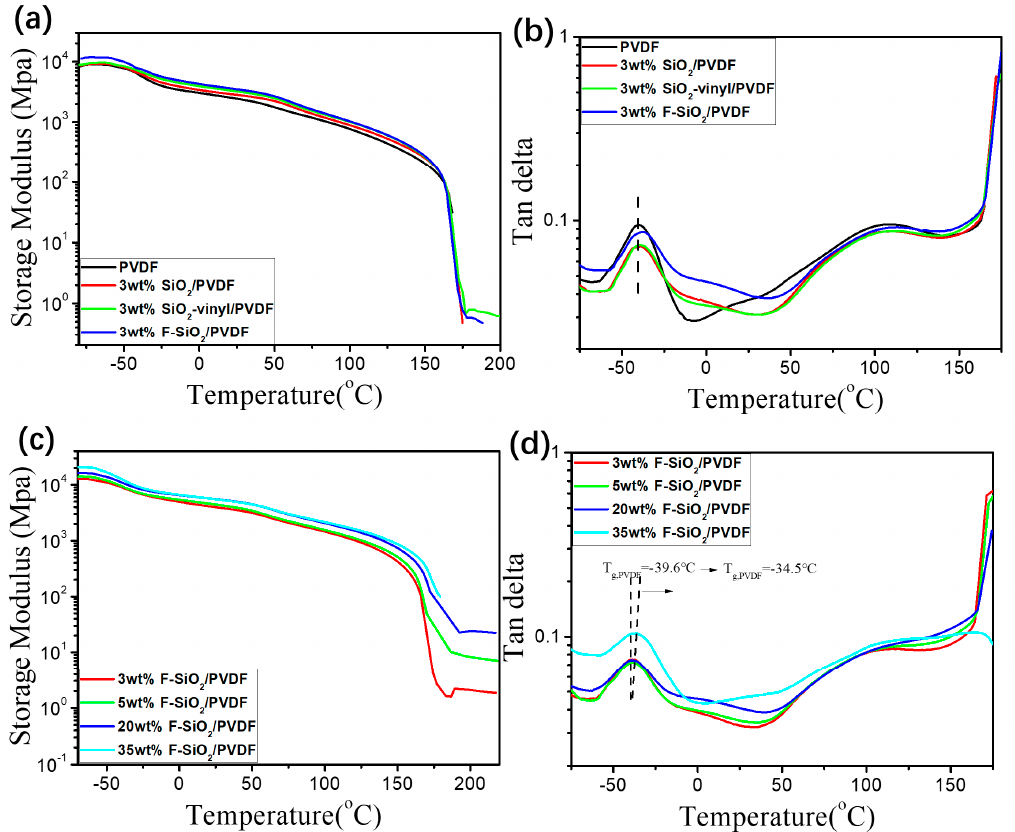
Figure 10. Storage modulus ( a ) and Loss tangent ( b ) as a function of temperature with a frequency of 5 Hz for the PVDF matrix with 3 wt% of SiO 2 , SiO 2 -vinyl, and F-SiO 2 , respectively. Storage modulus ( c ) and Loss tangent ( d ) as a function of temperature with a frequency of 5 Hz for the PVDF matrix with 3 wt%, 5 wt%, 20 wt%, and 35 wt% of F-SiO 2 , respectively. These results were obtained by dynamic thermomechanical analysis